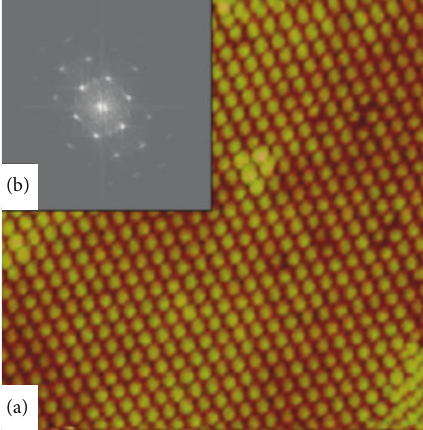
Figure 5: (a) AFM image of the top surface of the opal and (b) FFT of the image